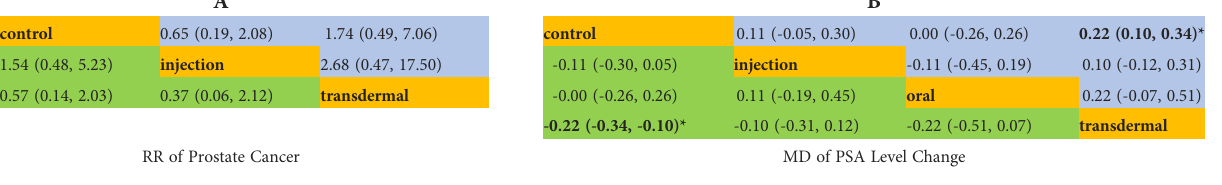
*Indicates the presence of statistical signi fi cance. The color shading in this table is used to highlight the results of indirect comparison of different testosterone preparations, which is consistent with the relevant literature of the Lancet